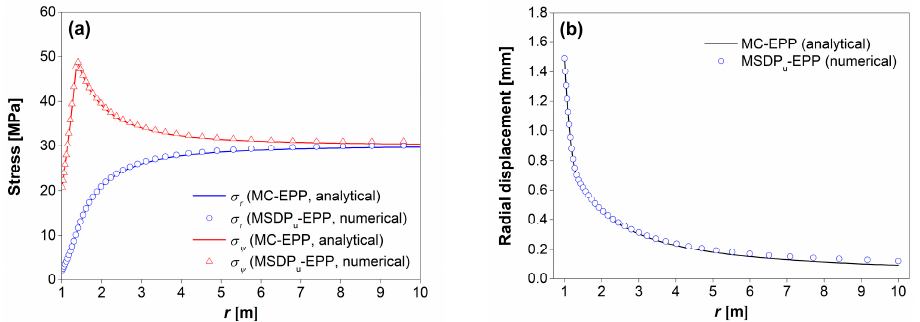
Figure 8. Distributions of the ( a ) stresses and ( b ) radial displacements, obtained from the numerical simulation with FLAC3D MSDP u ‐ EPP model and calculated with the analytical solutions of Salençon [38,39].